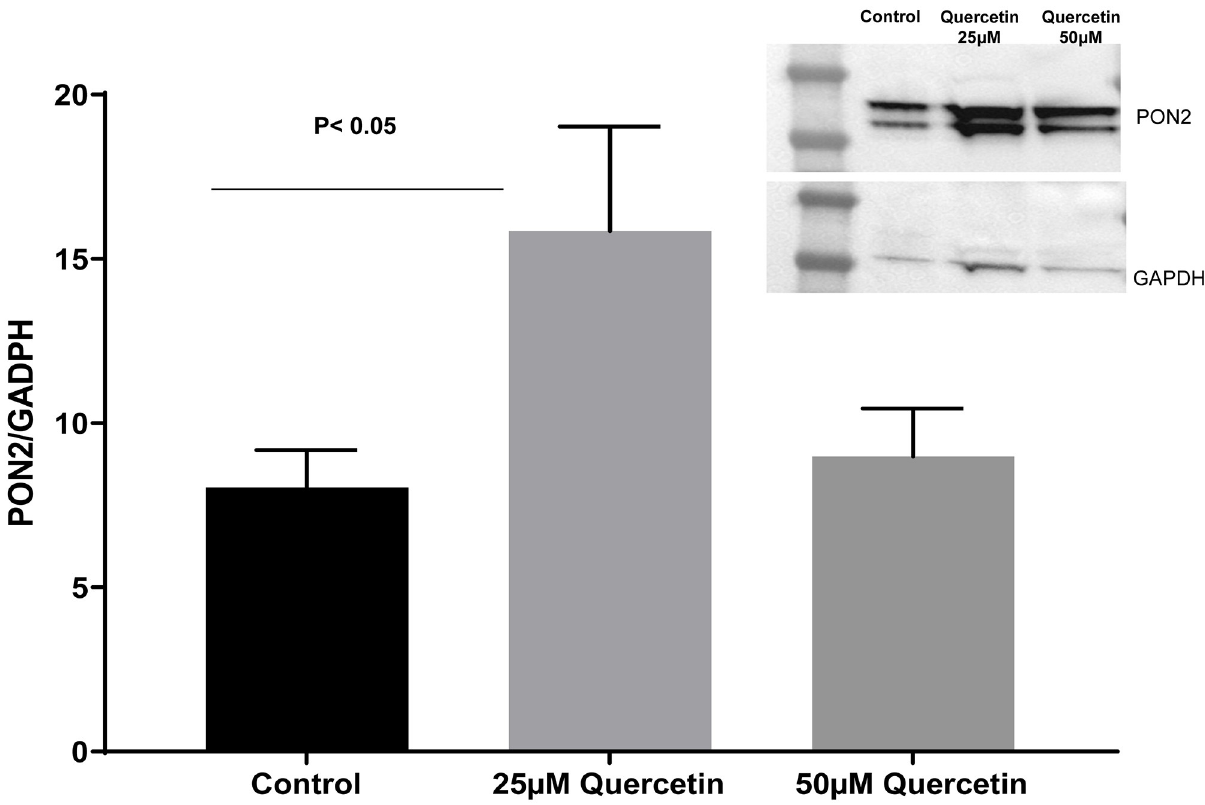
Fig 4. Ciliated, mucus-producing primary airway epithelial cells, maintained for 21 days in air-liquid interface (ALI) were treated with 25 μ M or 50 μ M of quercetin. 25 μ M quercetin significantly increased PON2 protein levels compared to control. Densitometry of PON2 � p < 0.005, N = 3/group one-way